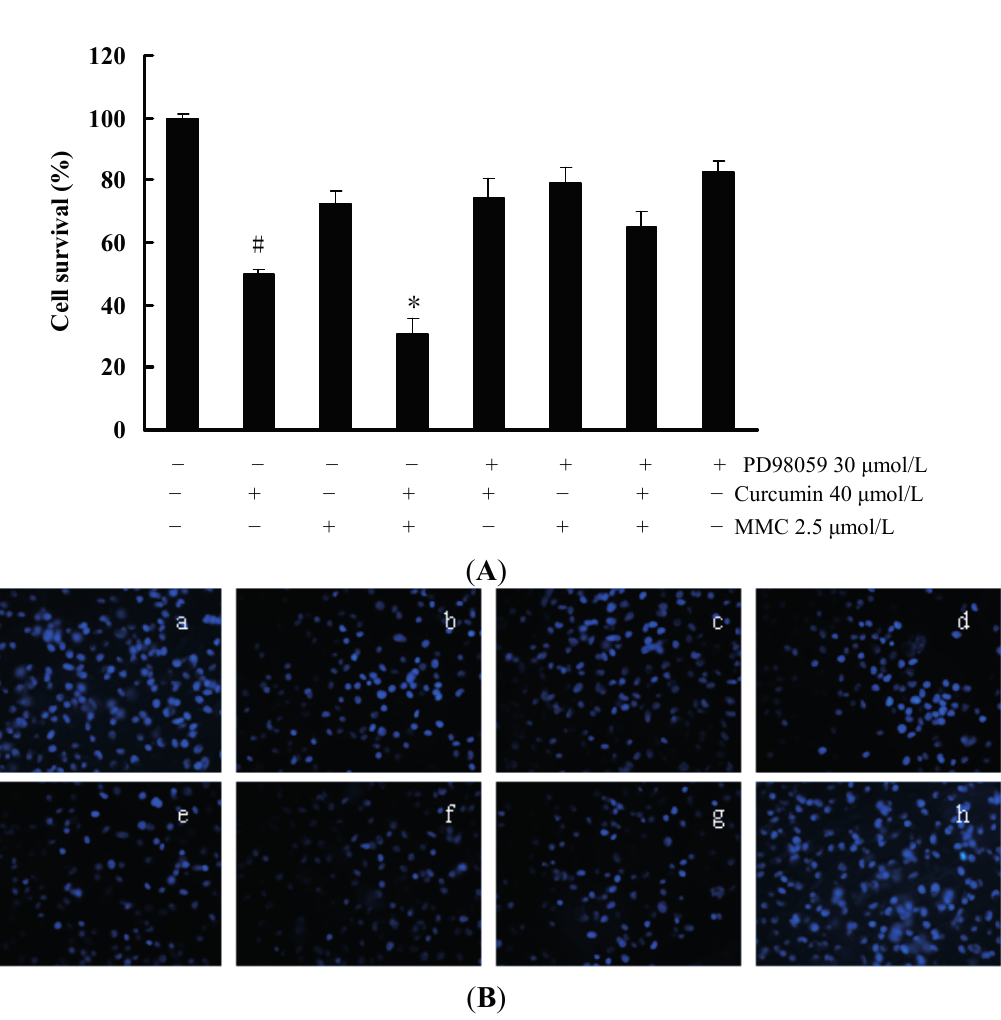
Figure 7. Effect of ERK-specific inhibitor PD98059 alone or PD98059 coupled with different drugs on cell proliferation and apoptosis in MCF-7 cells. ( A ) MCF-7 cells were pretreated with or without 30 μ mol/L PD98059 for 2 h before the cells were treated with both 40 μ mol/L curcumin and 2.5 μ mol/L MMC alone or combination for 48 h. MTT assay was performed as the description in Materials and Methods. All data were expressed as Mean ± SD from three independent experiments. * p < 0.05 versus curcumin/MMC coupled with PD98059. # p < 0.05 versus the combinatorial treatment of curcumin and MMC; ( B ) Cell morphology was observed by Hoechst 33258 staining, and then observed under fluorescence microscope (×200); and ( C ) the cells were subjected to the subsequent staining of Annexin V-PI and flow cytometric analysis. Data were expressed as Mean ± SE ( n = 3). * p < 0.05. ( a ) untreated control; ( b ) 40 μ mol/L curcumin alone; ( c ) 2.5 μ mol/L MMC alone; ( d ), curcumin/MMC combination; ( e ) 30 μ mol/L PD98059 combined with 40 μ mol/L curcumin; ( f ) 30 μ mol/L PD98059 combined with 2.5 μ mol/LMMC; ( g )